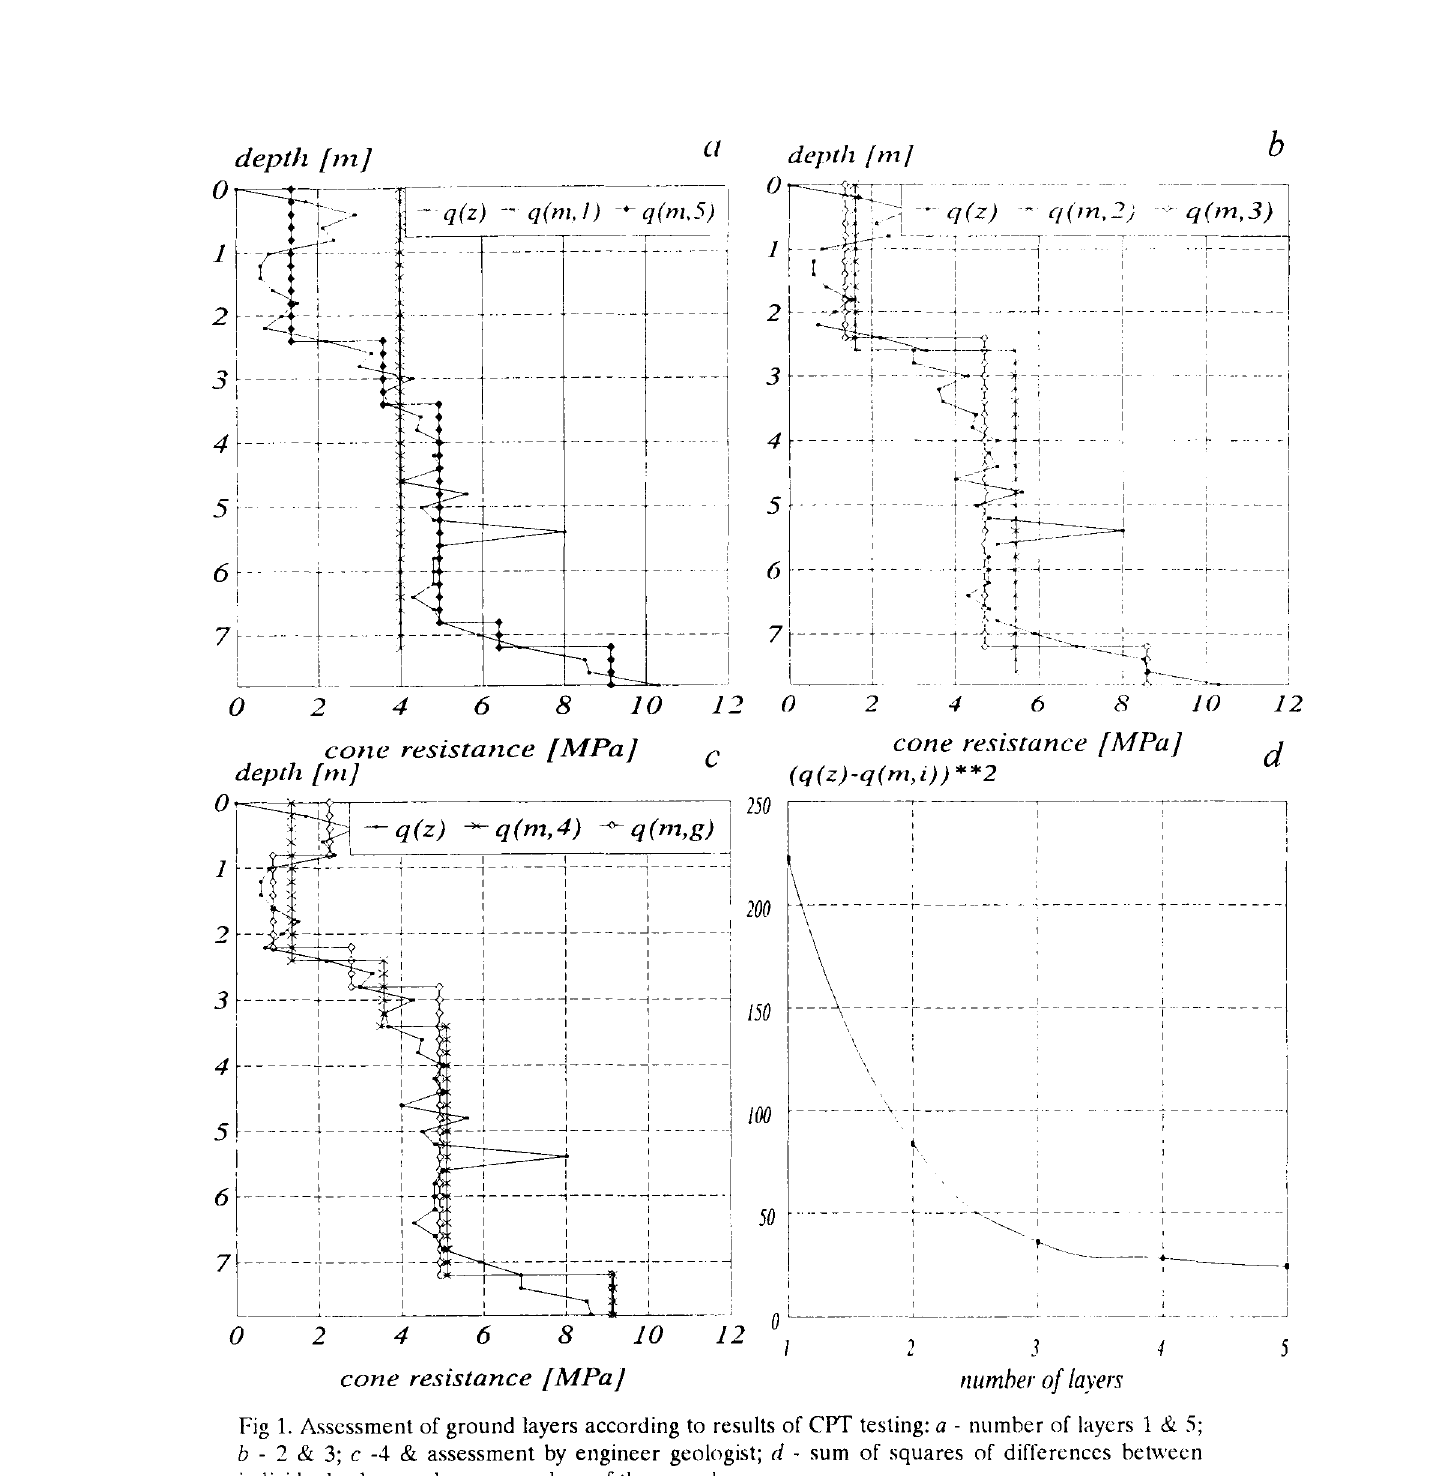
Fig 1. Assessment of ground layers according to results of CPT testing: a- number of layers 1 & 5; b - 2 & 3; c -4 & assessment by engineer geologist; d - sum of squares of differences between individual values and average values of the same